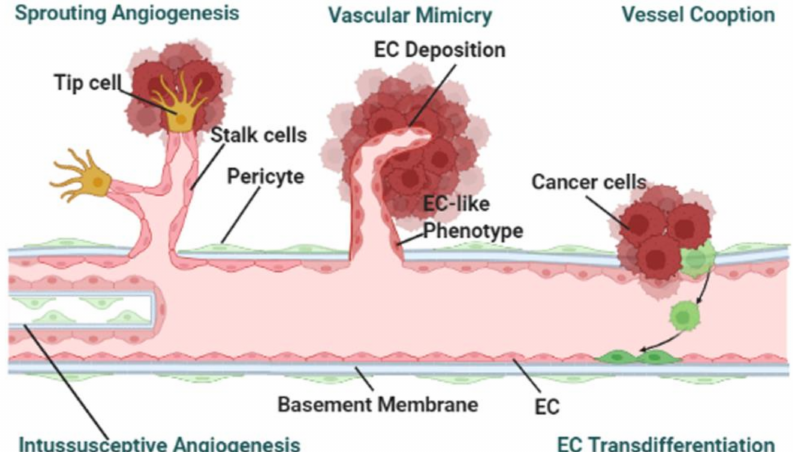
Figure 3. Tumor endothelial cells vascularize in different mechanisms: During sprouting angiogenesis, endothelial cells respond to proangiogenic factors to form a dynamic of stalk and migrating tip cells that control and guide the sprouts. Intussusceptive angiogenesis forms hollow transcapillary pillars and splits into 2 parallel vessels. In vessel co-option, cancer cells collaborate with adjacent normal tissue vasculatures and thus, incorporate the vessels into the tumor. In some cancers, a non-endothelial blood irrigation system is developed where cancer cells eventually transdifferentiate into endothelial cells, a process known as vascular mimicry. Cancer-on-chip models are heavily concentrated on articulating the process of sprouting angiogenesis in